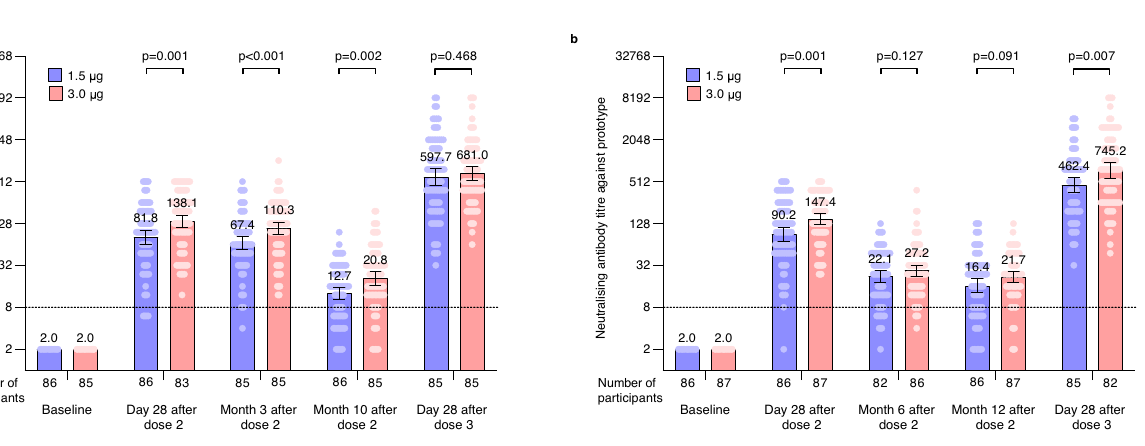
GMTs and corresponding 95%CI were calculated on the basis of standard normal distributions of log-transformed antibody titres. Numbers above the short hor- izontal lines are p values of comparisons between 1.5 μ g group and 3.0 μ g group using group t test with log-transformation (two-sided). The dotted horizontal line represents the seropositivity threshold (1:8). Titres lower than the limit of detection (1:4) are presented as half the limit of detection. GMT geometric mean titre.